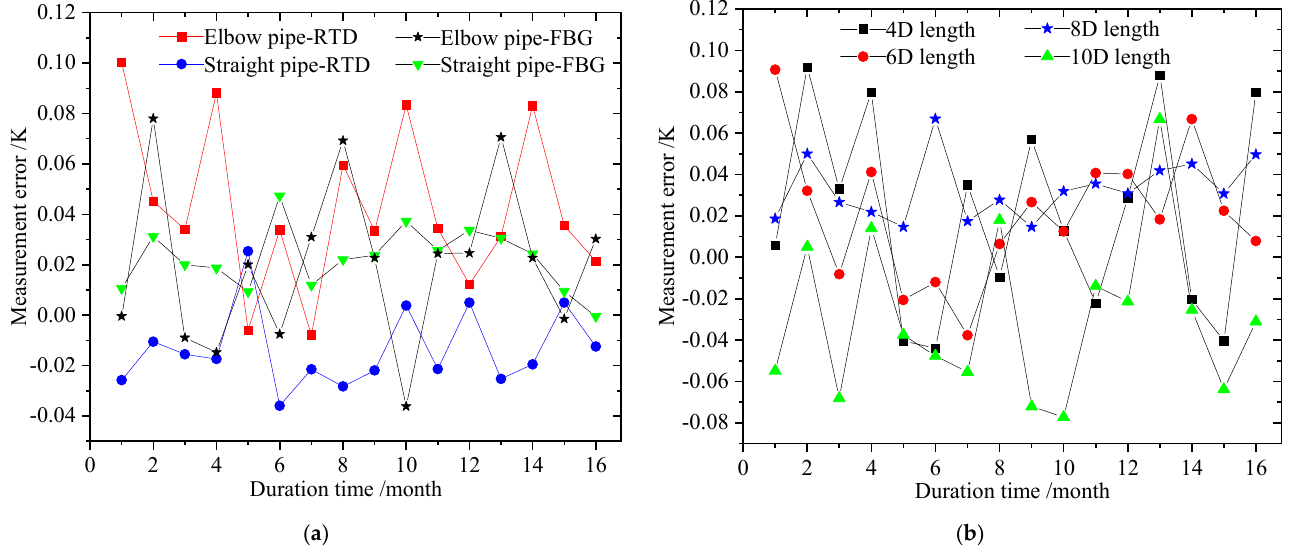
Figure 10. Experimental results: ( a ) influence of upstream vibration/turbulence; ( b ) influence of measuring position of chiller pipeline.